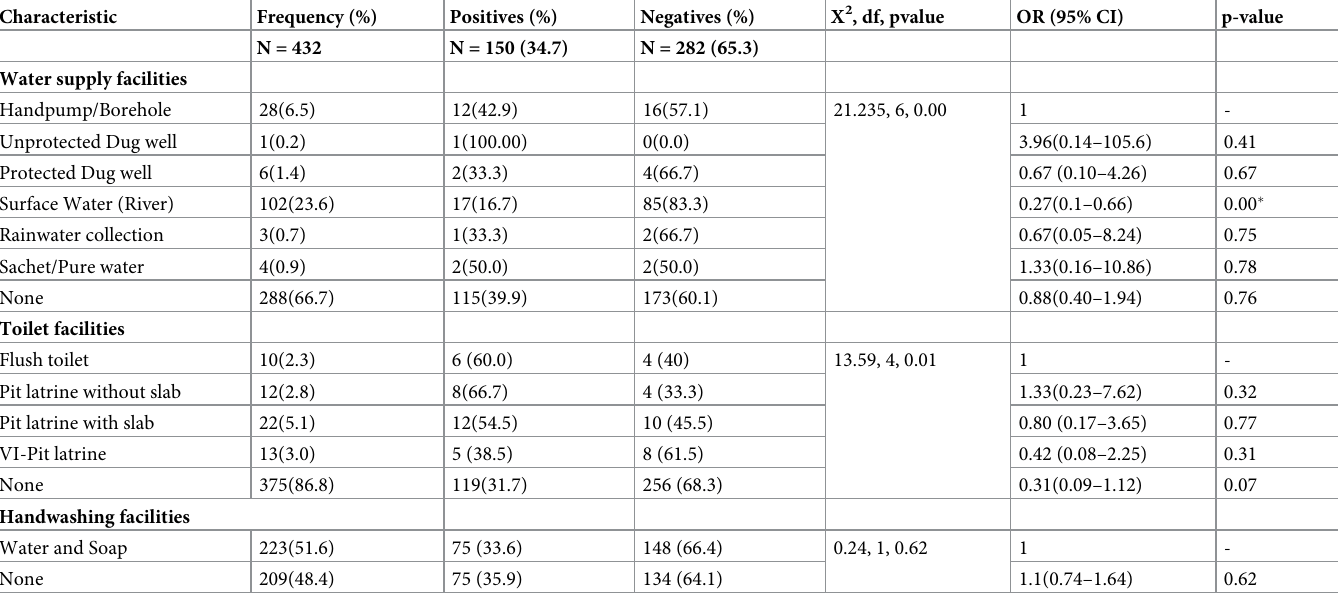
Table 3. Access to water, sanitation and hygiene (WASH) facilities and prevalence of schistosomiasis.